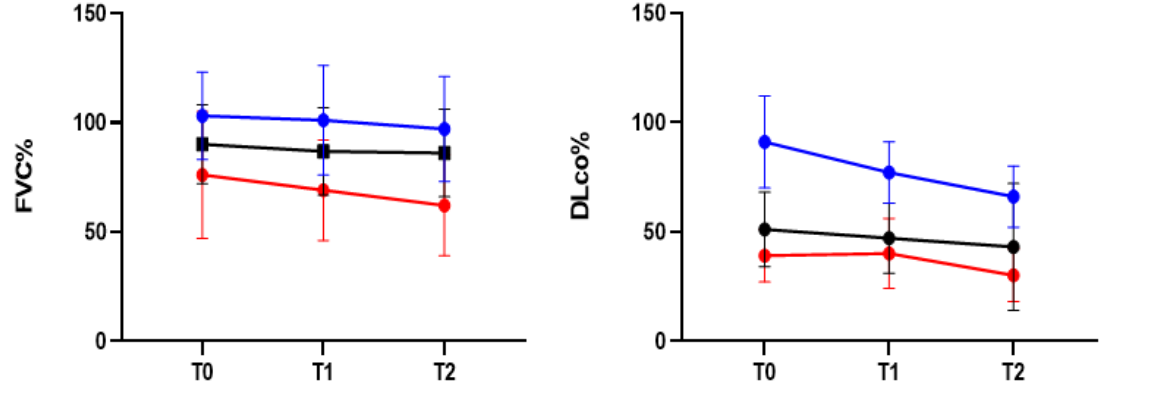
Figure 2. FVC and DLco percentages at diagnosis (T0) and at one- (T1) and two-year (T2) follow- up.